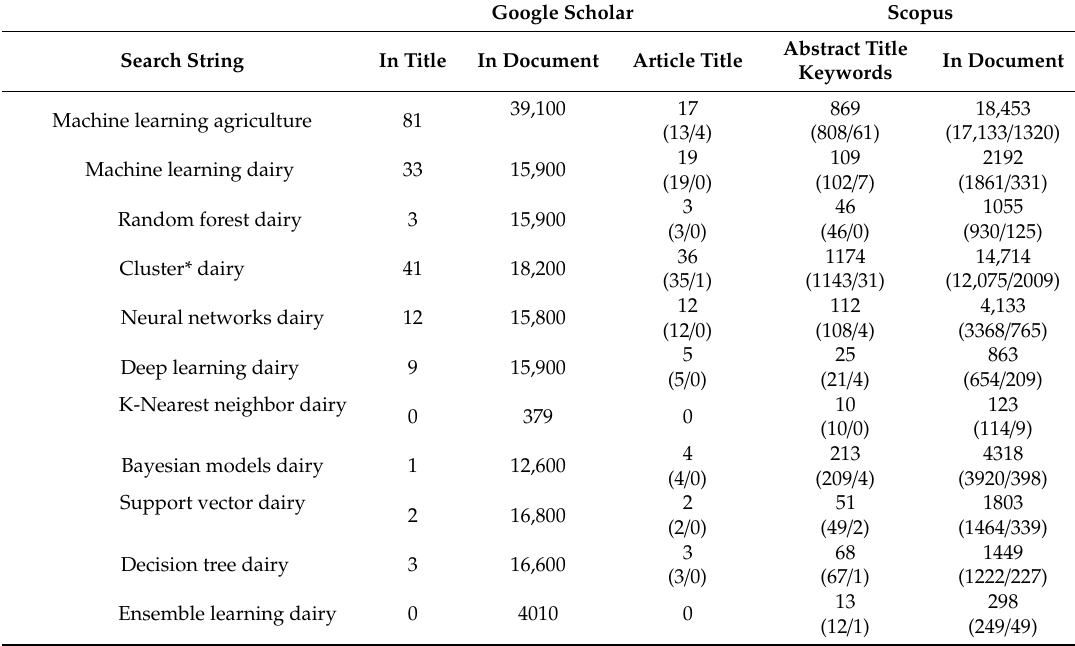
Table 1. Search strings and results of peer-reviewed papers (articles / reviews) in Scopus and of all articles in Google Scholar since 2015; searches last performed on 24.06.2020 and 25.06.2020 in Scopus and Google Scholar, respectively. The indents in the column “search string” indicate the hierarchical structure of the search